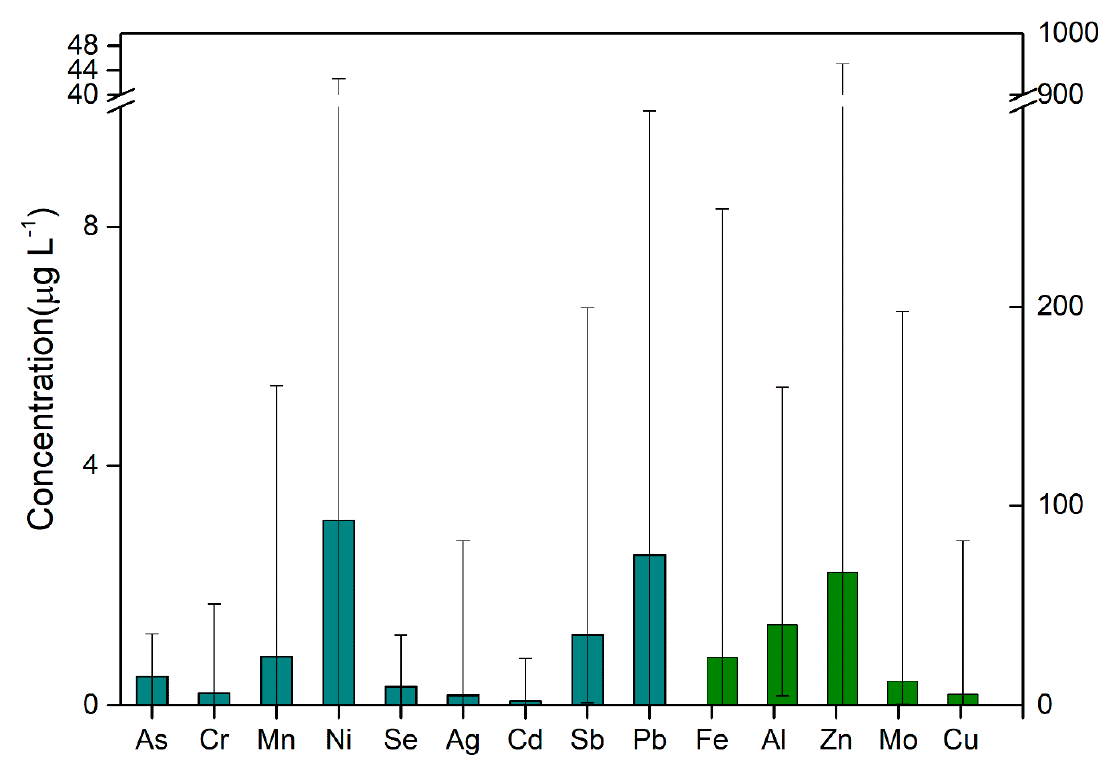
Figure 3. Distribution of heavy metal concentration in the end water of Shanghai pipeline network.